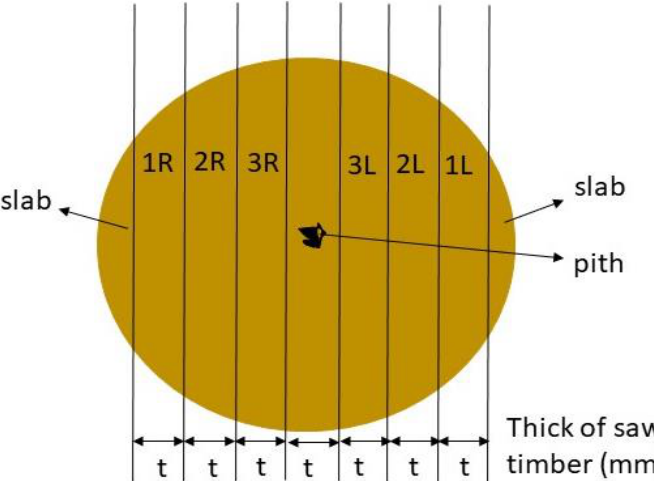
Figure 2. Cutting of infected logs by using live sawing technique. The numbering of 1R, 2R, 3R, 1L, 2L, 3L indicate the number and position (right (R) and left (L)) of boards obtained during sawing. The number of boards obtained depends on the diameter size of the log.